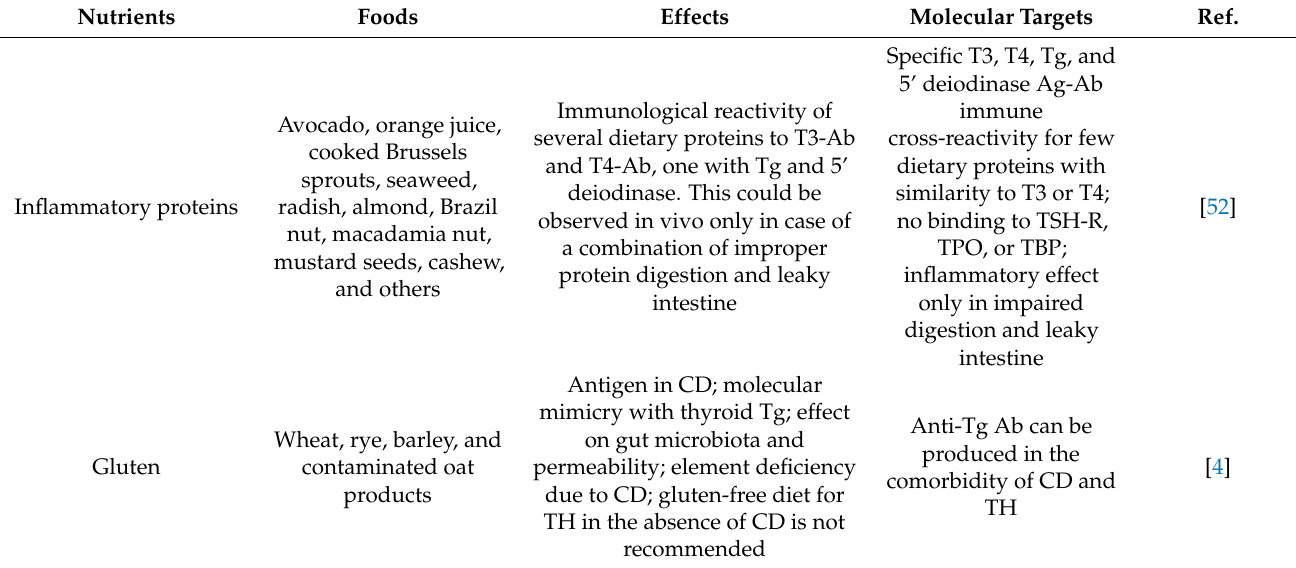
Table 4. Inflammatory